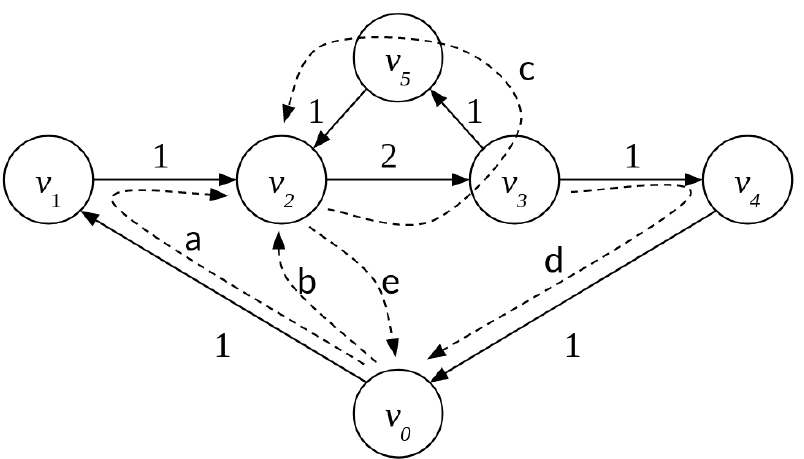
Figure 8. Example of gridlock resolution scenario. Sequence of steps depicted with dashed arrows is marked with letters from “a” to